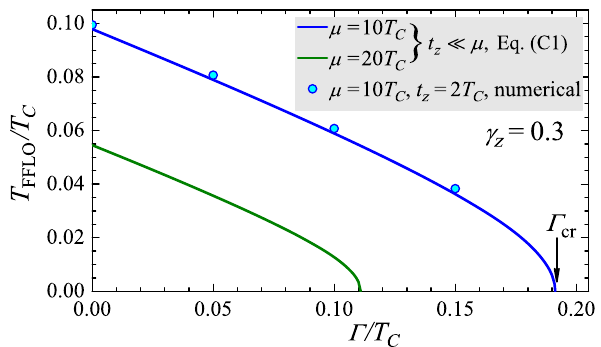
FIG. 10. The representative dependences of the FFLO- instability temperature on the scattering broadening Γ . The solid lines are obtained from Eq. (C1) valid in the limit t solid symbols are the transition points for plots in Fig.